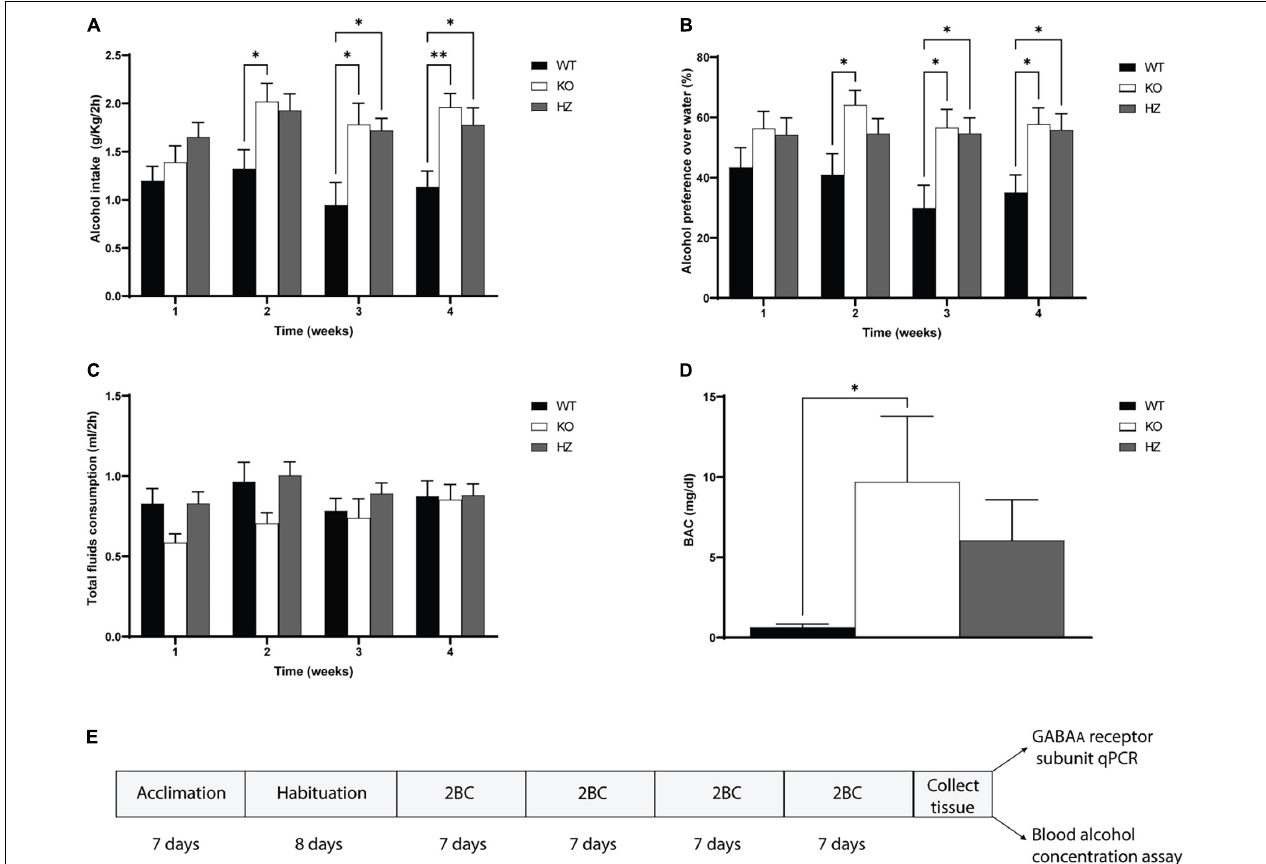
FIGURE 1 | Limited access 2-bottle choice (2BC) drinking paradigm to study alcohol intake, preference, total fluid consumption, and blood alcohol concentration (BAC). (A) Total alcohol intake in GABA B ( 1 ) WT, KO, and HZ mice during the total period (4 weeks) of 2BC exposition (WT, n = 13; KO, n = 9; HZ, n = 15). (B) Alcohol preference to water during the 4 weeks of 2BC; (WT, n = 13; KO, n = 9; HZ, n = 15). (C) Total fluid consumption recorded in GABA B ( 1 ) WT, KO, and HZ during the 2BC drinking paradigm; (WT, n = 13; KO, n = 9; HZ, n = 15). (D) BAC in GABA B ( 1 ) WT, KO, and HZ mice was determined at the end of the last drinking session (WT, n = 13; KO, n = 8; HZ, n = 14). Post hoc test ( ∗∗ p < 0.01; ∗ p < 0.05). (E) Schematic representation of experimental timeline. All data are expressed as mean ±